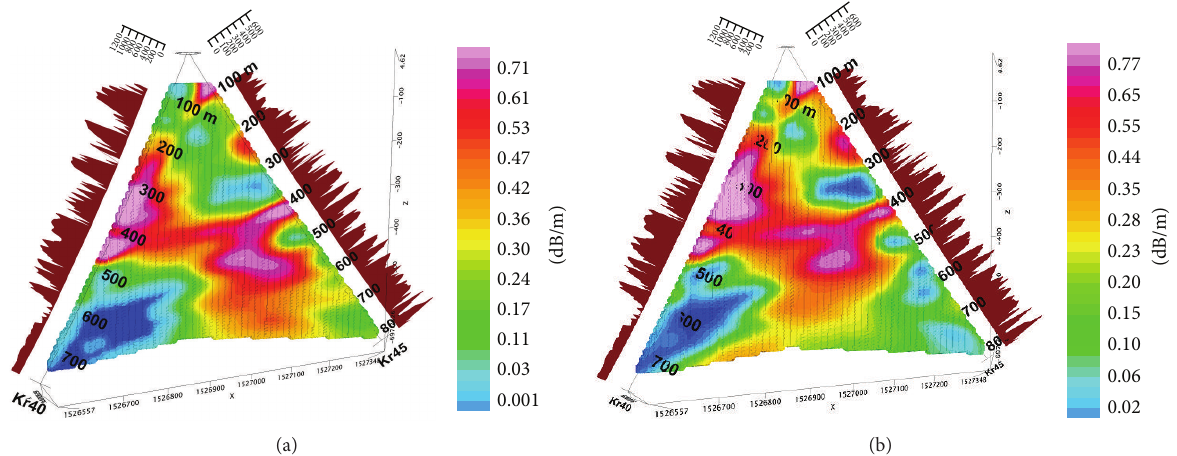
Figure 9: The attenuation distribution of section OL-KR40–OL-KR45: (a) 312.5 kHz, (b) 625 kHz. Short normal curves ( Ω m) are added to the images and plotted as brown filled